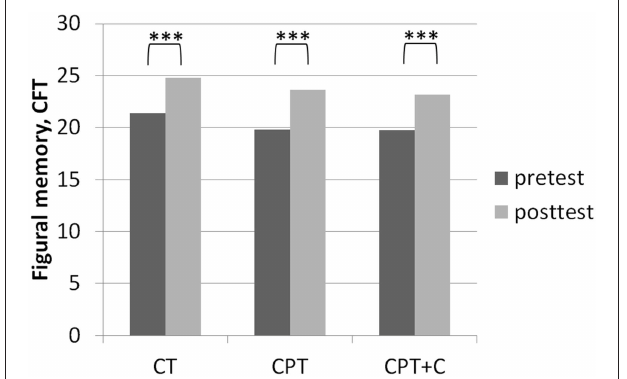
FIGURE 3 | Results of post-hoc analyses of within-subject factor Time for executive functions assessed with the Regensburger Wort Flüssigkeits-Test (RWT, Aschenbrenner et al., 2000) in each training group separately. * p ≤ 0.05 ; *** p ≤ 0.001 .